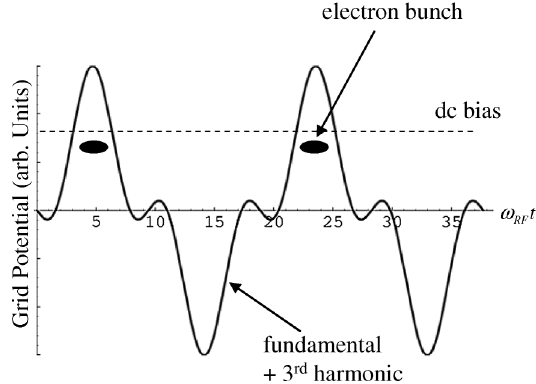
FIG. 5. Waveform consisting of the fundamental and third harmonic (blue curve). In this figure, the amplitude of the third harmonic is taken to be half that of the fundamental. The dc bias (dashed line) limits the electron bunch length to (cid:1) 90 (cid:9) of the third harmonic, while filling every bucket.